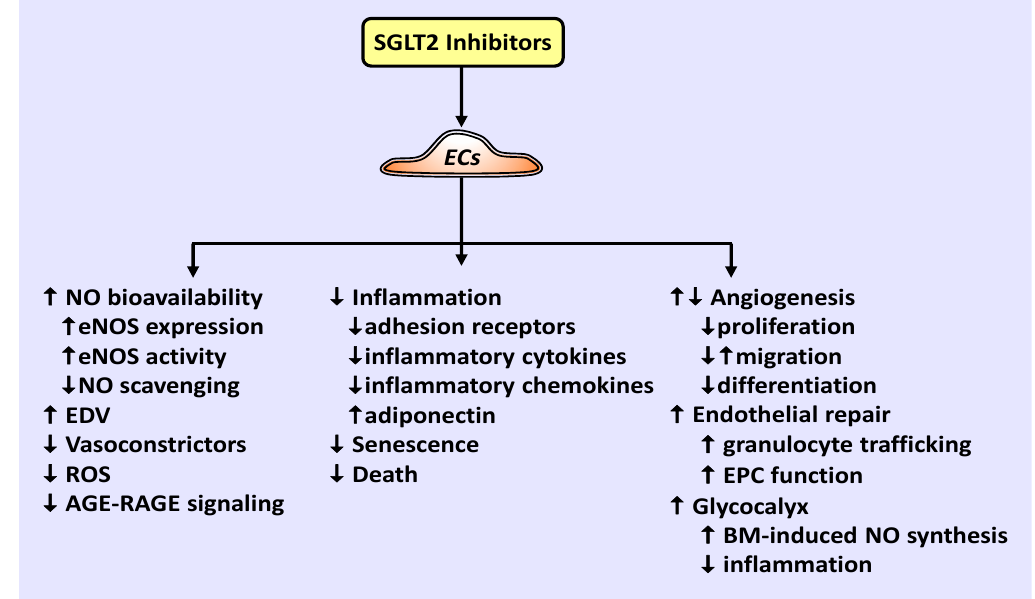
Figure 1. Effect of SGLT2 inhibitors on EC function. SGLT2 inhibitors increase NO bioavailability by elevating eNOS expression and activity, and/or limiting NO scavenging, thereby promoting endothelium-dependent vasodilation (EDV). In addition, SGLT2 inhibitors block the generation of vasoconstrictors and ROS, the activation of the AGE-RAGE signaling pathway, and EC death and senescence. They also attenuate inflammation by inhibiting the endothelial expression of adhesion receptors, inflammatory cytokines and chemokines, while enhancing the expression of adiponectin. Furthermore, SGLT2 inhibitors stimulate endothelial repair by improving EPC function and increasing the trafficking of granulocytes to injured arteries. SGLT2 inhibitors also preserve the structural integrity of the endothelial glycocalyx, resulting in sustained biomechanical (BM)-induced NO synthesis and a reduction in inflammation. Finally, SGLT2 inhibitors suppress EC proliferation and differentiation, but elicit variable effects on angiogenesis and EC